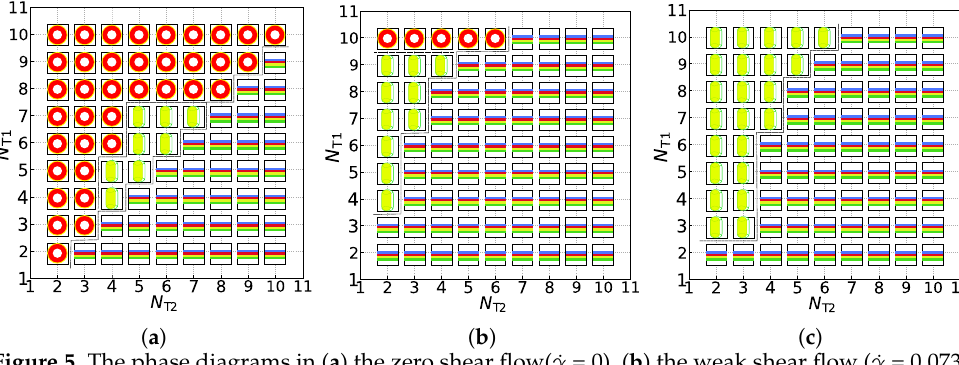
Figure 5. The phase diagrams in ( a ) the zero shear flow( ˙ γ = 0), ( b ) the weak shear flow ( ˙ γ = 0.073), and ( c ) the strong shear flow ( ˙ γ = 0.168). The phase symbols represent the asymmetric vesicle, asymmetric tube and asymmetric membrane,